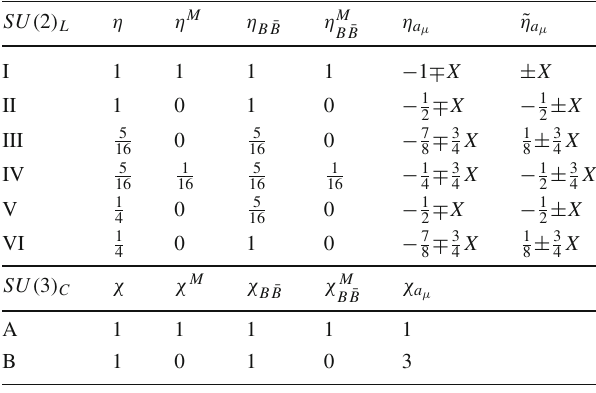
Table 3 SU ( 2 ) and SU ( 3 ) factors entering Wilson coefficients C box